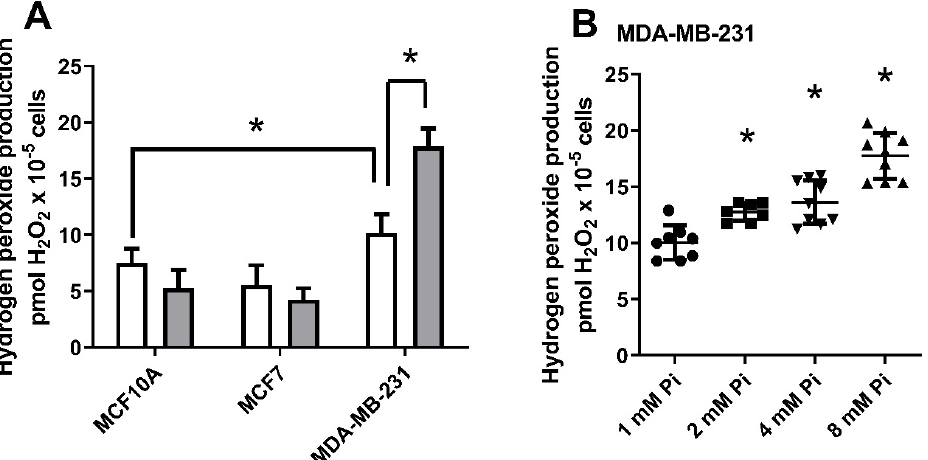
Figure 4. Influence of high Pi concentrations on hydrogen peroxide production by breast cell lines. H 2 O 2 production was evaluated for 1 h in different breast cell lines: MCF10-A, MCF-7, and MDA-MB-231, as indicated on the abscissa, after 24 h treatment with basal Pi (1 mM Pi, white bars) or high Pi (8 mM Pi, grey bars) ( A ). MDA-MB-231 was treated at various Pi concentrations (1, 2, 4, and 8 mM Pi) for 24 h, and H 2 O 2 production was evaluated at 1 h, as described in Section 4 ( B ). Bars represent mean ± SE of at least 3 independent biological samples. * p < 0.05 indicates changes significantly different, as assessed by ANOVA followed by Tukey’s multiple comparison test.